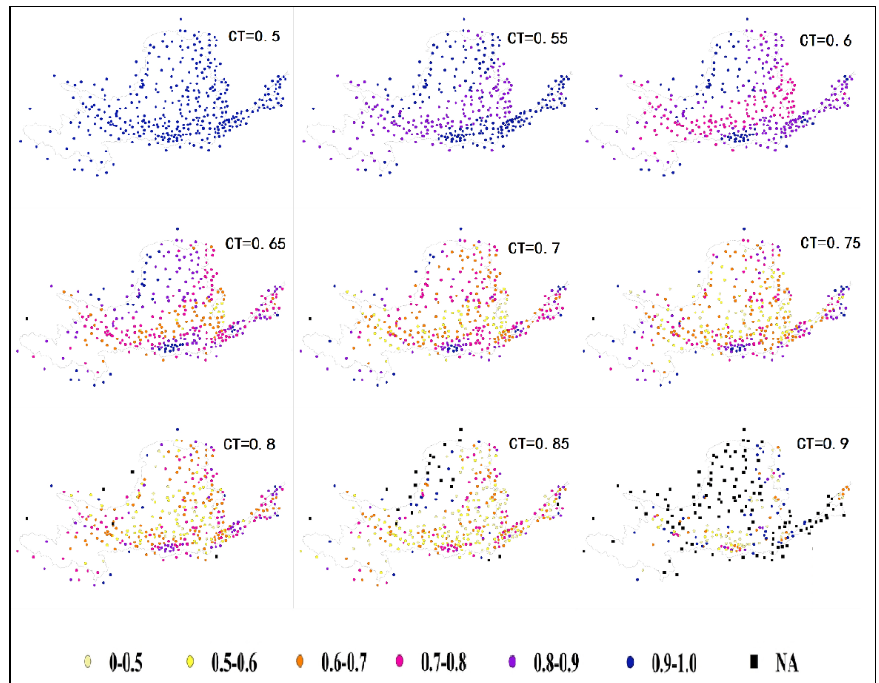
Figure 2. Clustering coefficient values of a P-network for nine threshold values.